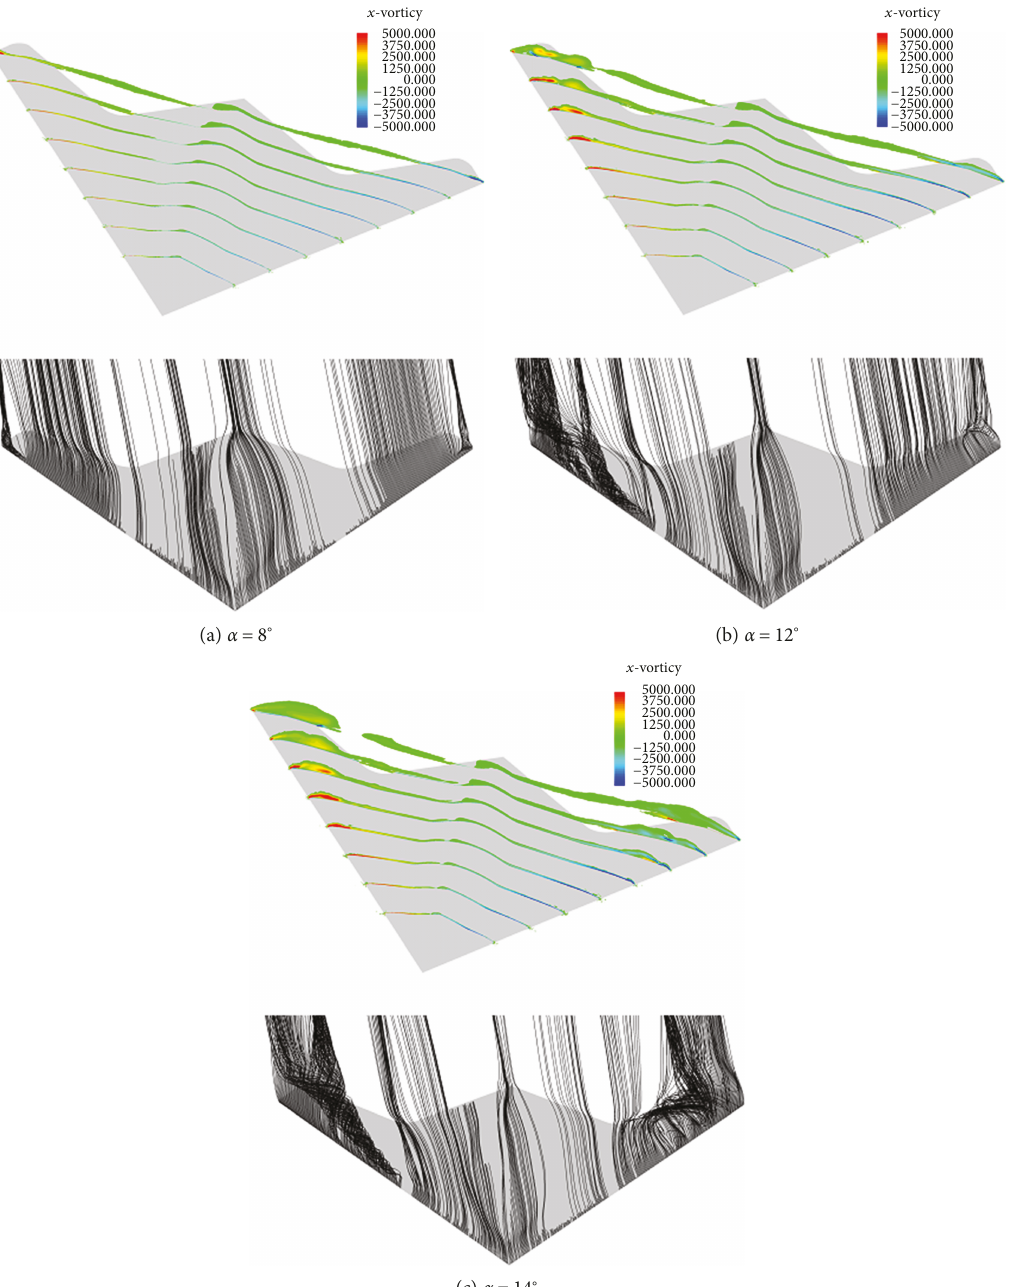
Figure 14: Streamwise vorticity contours (upper) and streamlines (lowers) at the side slip angle 8 °